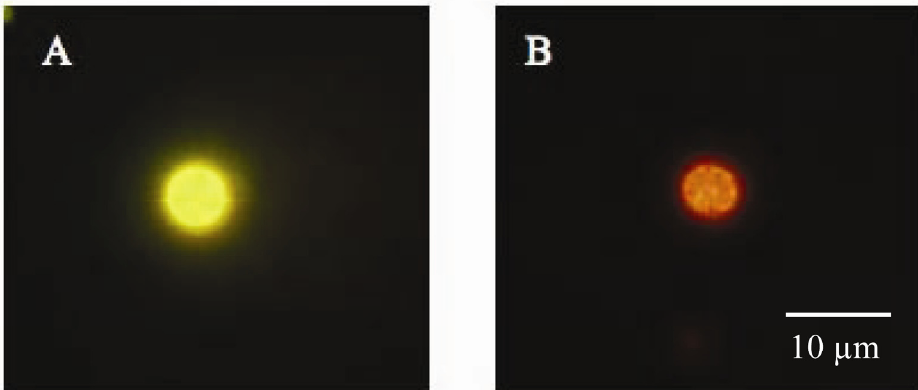
Figure 1. Immunofluorescence detection of IdiA accumulation in an autofluorescent C. watsonii cell labeled with Qdot 605 secondary antibody conjugate against the IdiA primary antibody prior to photobleaching (A). The same field after photobleaching exhibiting strong Qdot 605 labeling. Photograph enlarged for